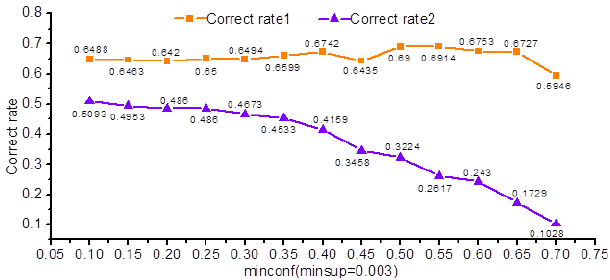
Fig. 8. Minconf and the correct rate when minsup = 0.003.